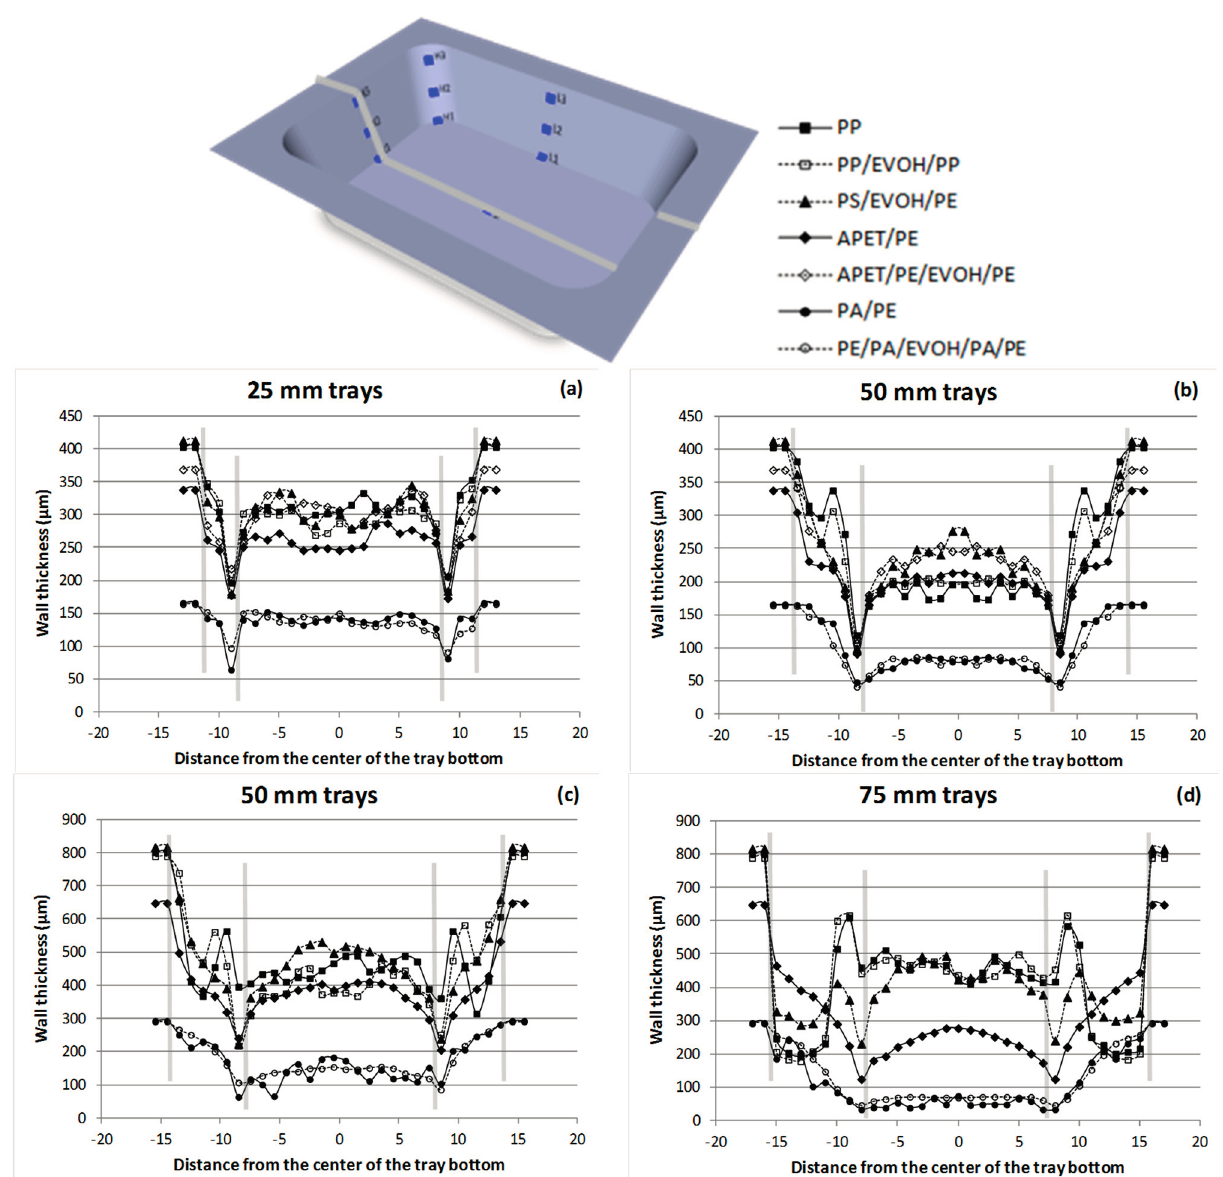
Figure 6. Wall thickness distribution (µm) along a cross-section through the short side walls of the 25-mm ( a ) and 50-mm ( b ) trays and the thicker 50-mm ( c ) and 75-mm ( d ) trays. Distance from the center of the tray bottom is expressed in